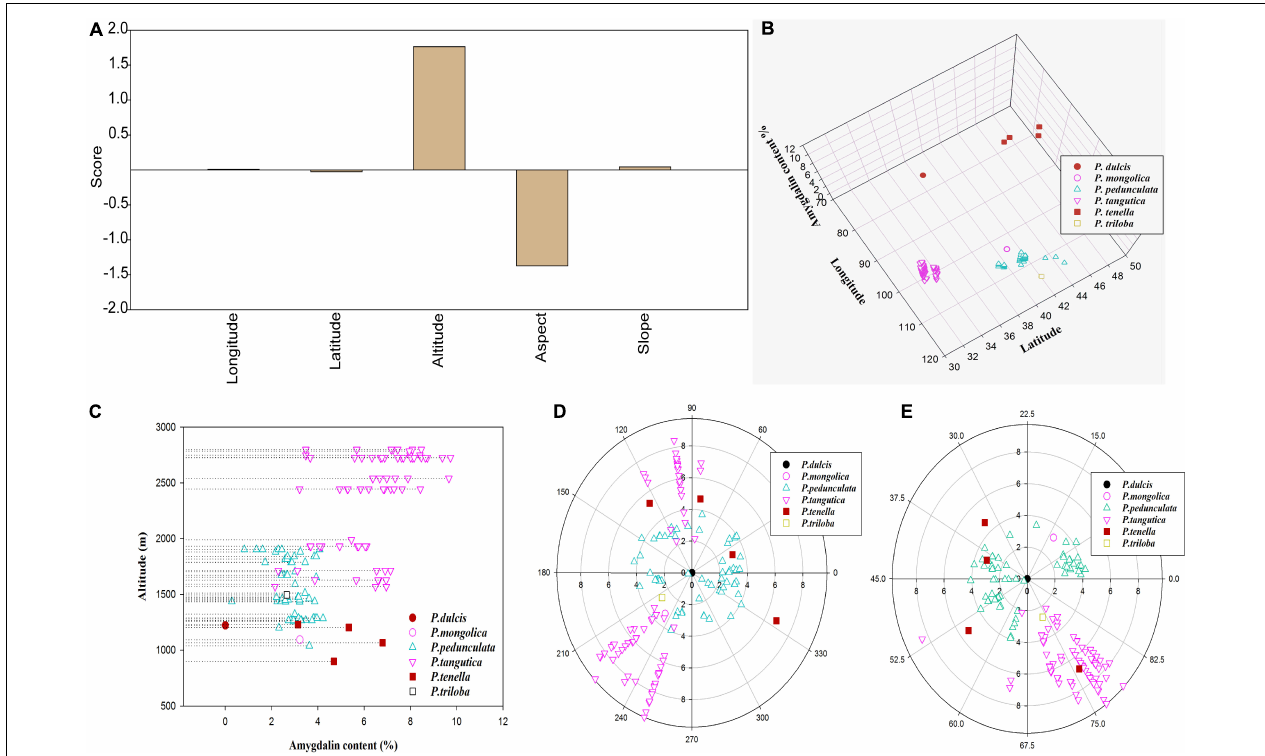
FIGURE 3 | Factor analysis scores of amygdalin content in five topographic datasets (longitude, latitude, altitude, slope, and aspect) of six almond species (A) ; amygdalin content in different longitudes, latitudes (B) , and altitudes (C) ; scatter plot of amygdalin content in different aspects (D) and slopes (E) .